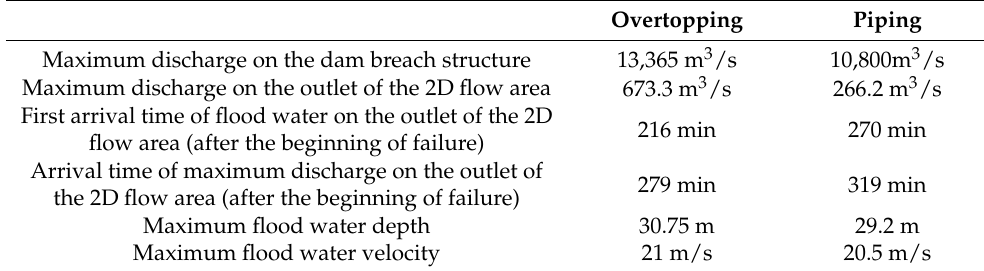
Table 6. Critical simulation outputs of the dam failure scenarios.